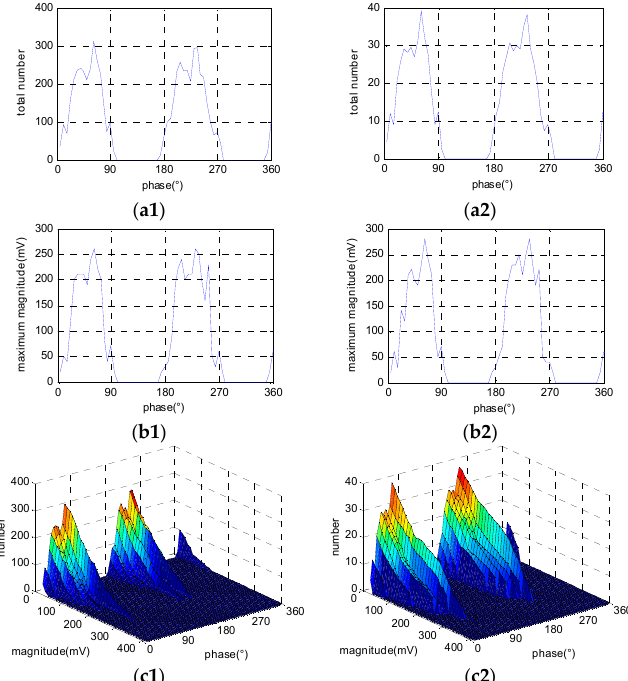
Figure 7. PD pattern charts of the air ‐ void discharge model. ( a1 )–( c1 ) are the φ ‐ n tot , φ ‐ V max , and φ ‐ V ‐ n pattern charts of data acquired by the intelligent sensor, respectively; ( a2 )–( c2 ) are the φ ‐ n tot , φ ‐ V max , and φ ‐ V ‐ n pattern charts of data acquired by the oscilloscope, respectively.